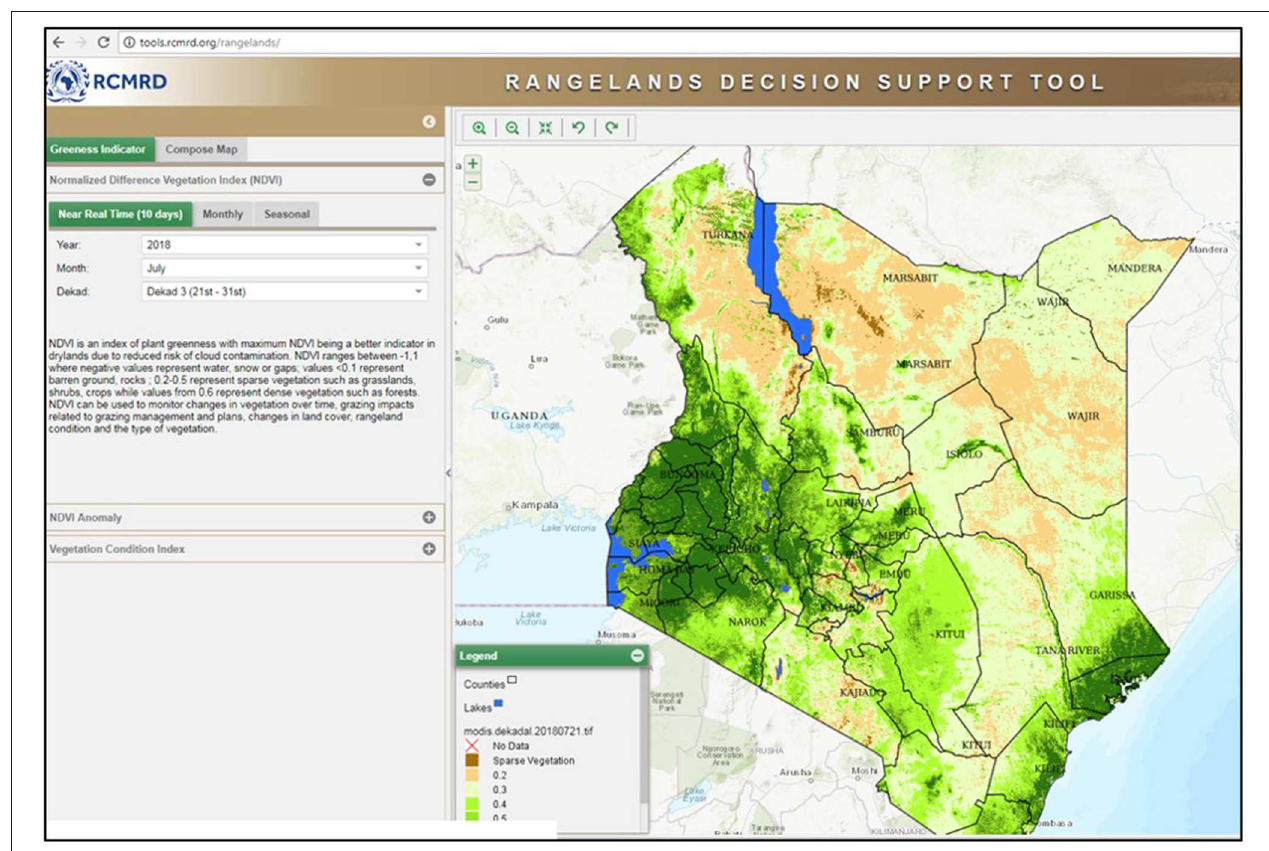
FIGURE 3 | The rangeland decision support tool